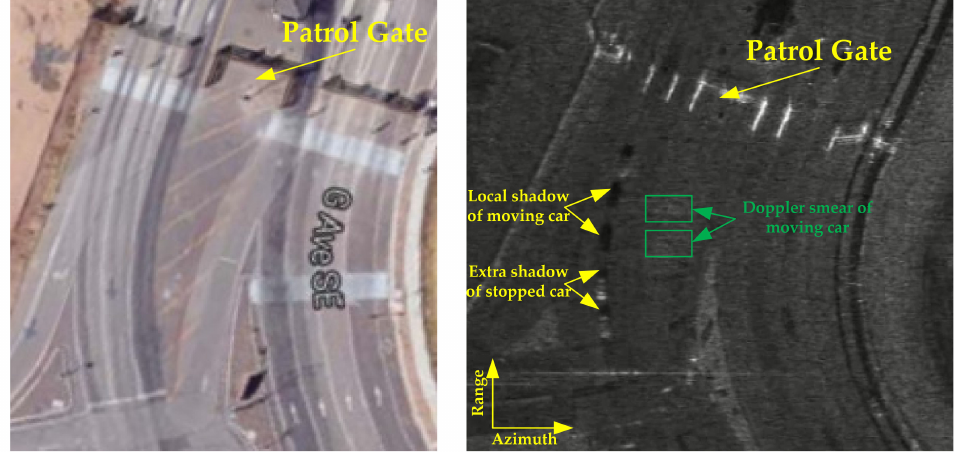
Figure 9. Shadow features of ground moving car shown in real ViSAR